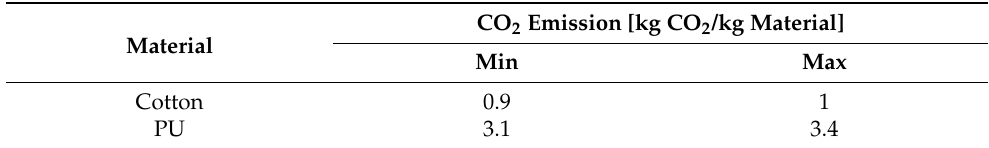
Table 4. CO 2 emissions, expressed in kgCO 2 /kg Material, for each material masks are made obtained by the software Ces Selector.